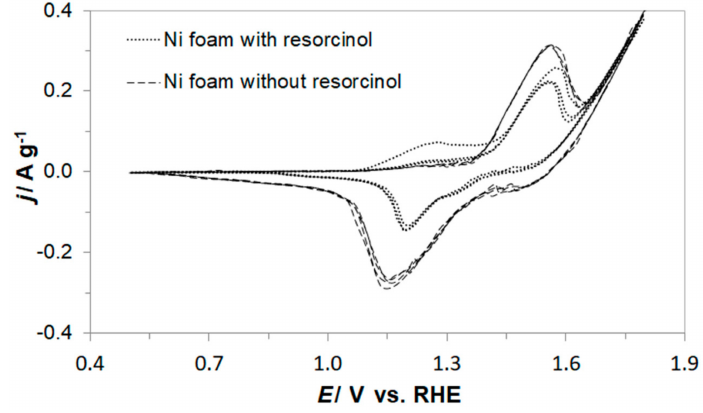
Figure 3. Cyclic voltammograms recorded on Ni foam electrode surface in 0.1 M NaOH supporting solution, carried out in the absence and presence of resorcinol (at 1 × 10 − 3 M), at a sweep-rate of 50 mV s − 1 .